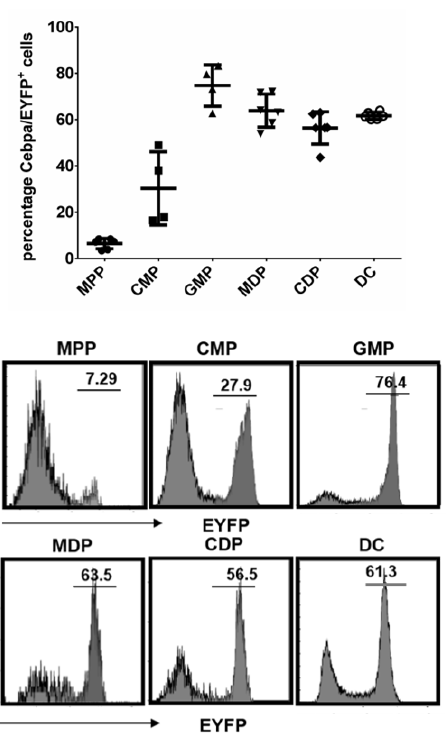
Figure 1. Cebpa /EYFP expression in distinct progenitor cell compartments and mature splenic Figure 1. Cebpa / EYFP expression in distinct progenitor cell compartments and mature splenic CD11c + MHCII + dendritic cells (DCs). Data represent the mean (+ SD) percentage of Cebpa /EYFP − CD11c + MHCII + dendritic cells (DCs). Data represent the mean ( + SD) percentage of Cebpa / EYFP − positive cells of the given subpopulation obtained from 4–6 mice. positive cells of the given subpopulation obtained from 4–6